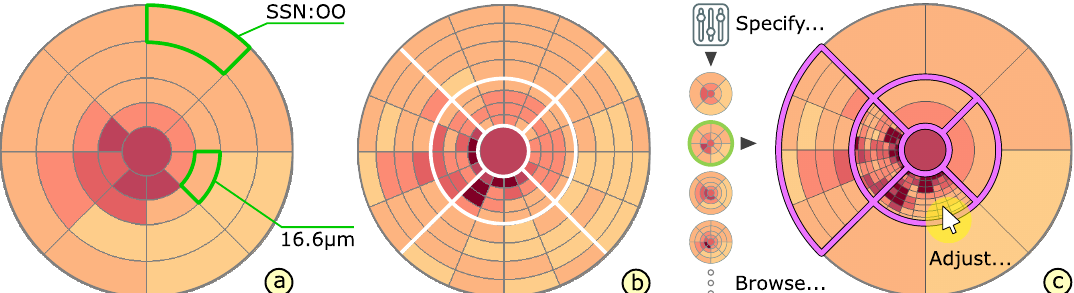
Figure 6. Interactive labeling and adaption of grids. The labeling of grids shows either numerical cell values or location-oriented cell names ( a ). White cell borders mark the layout of the standard ETDRS grid on top of a subdivided grid ( b ). The adaption of grids involves specifying initial grids, browsing through them, and adjusting cells of selected grids (purple borders) on demand ( c